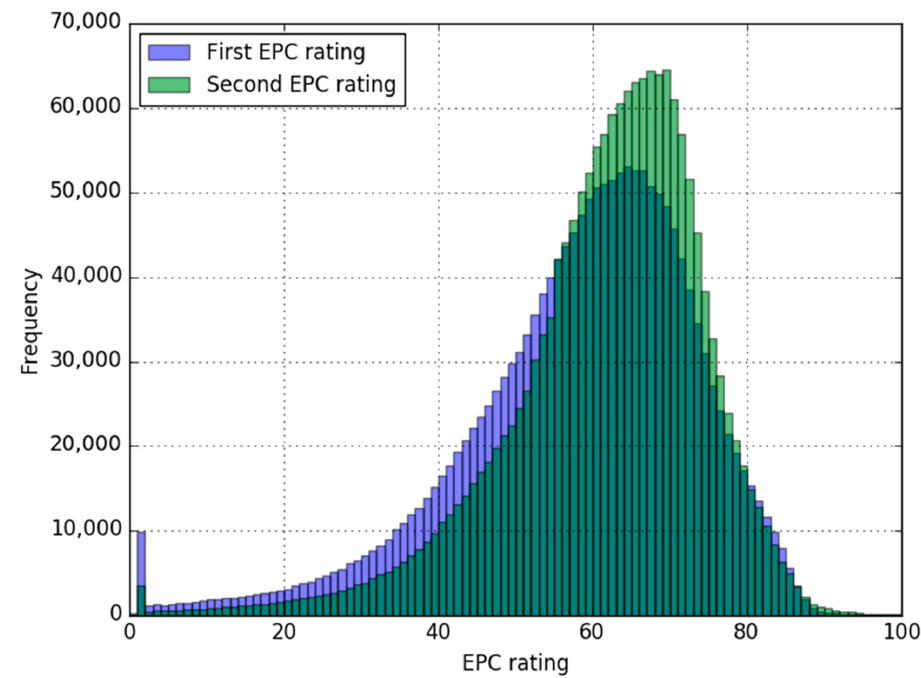
Figure 2. Histograms of first and second EPC ratings for the subset in the England and Wales dataset which have two ratings.